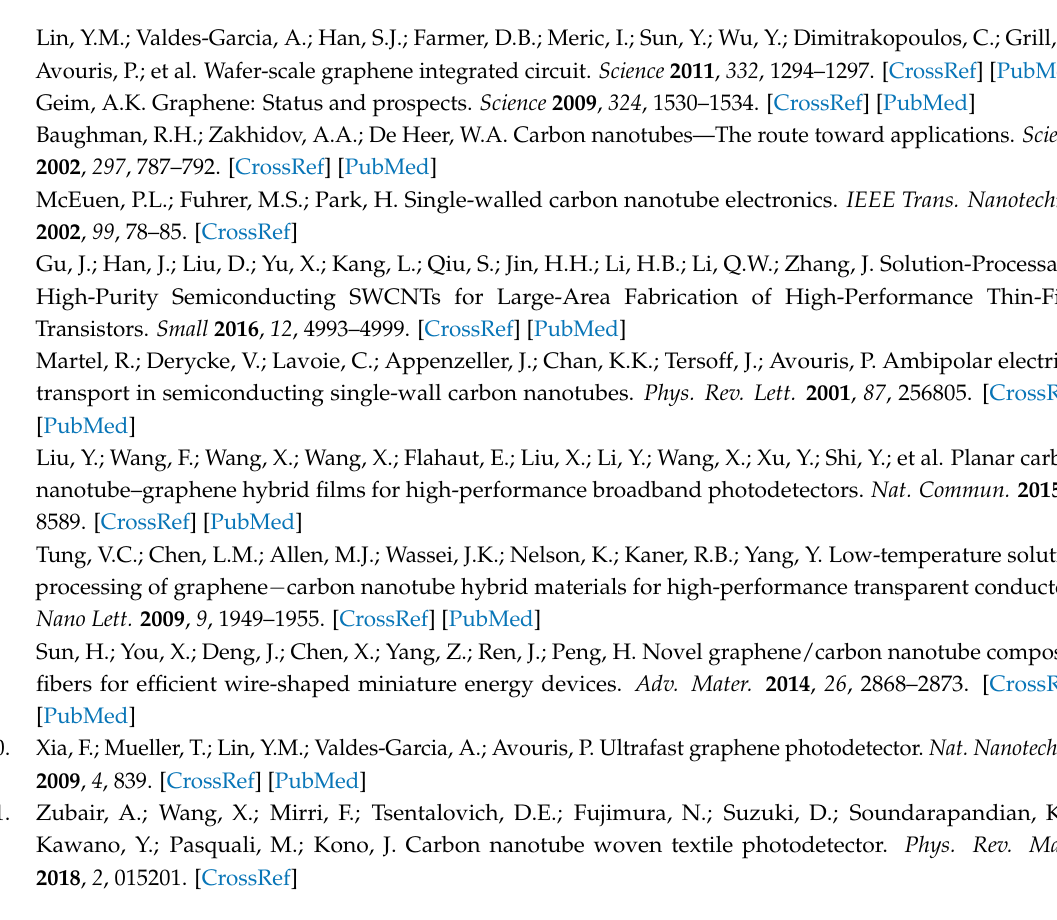
s1. Figure S1: The semiconducting characteristic of the SWCNTs.; Figure S2: The electrical characteristic curves of the carbon-based devices in log scale. Figure S3: The contact resistance effects in Carbon-based thin film transistors. Author Contributions: J.C. conceived and performed the experiments, analyzed the data, and wrote the paper. Z.A. provided the experimental materials and laboratory equipment and directed the research. Y.Z., X.G., and